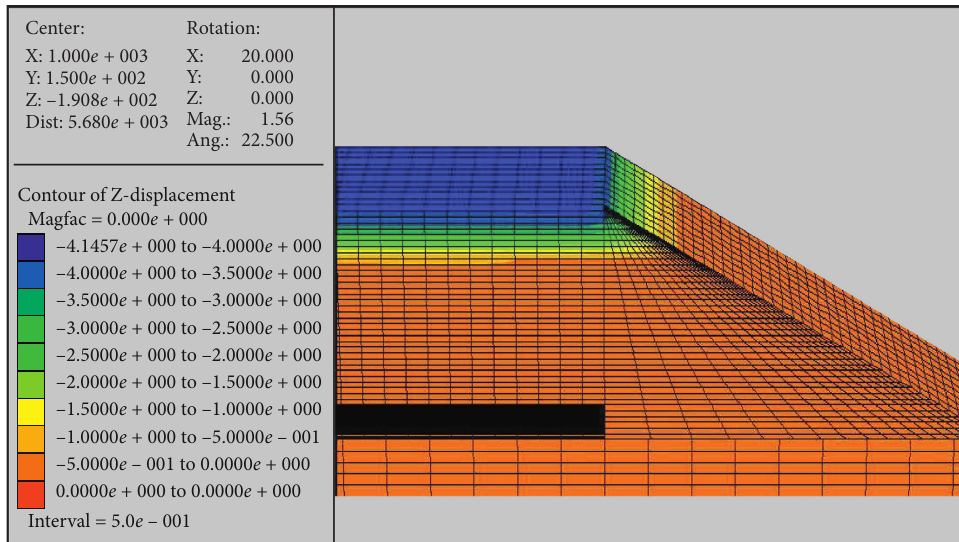
Figure 12: Vertical displacement after slope excavation in the presence of hydraulic